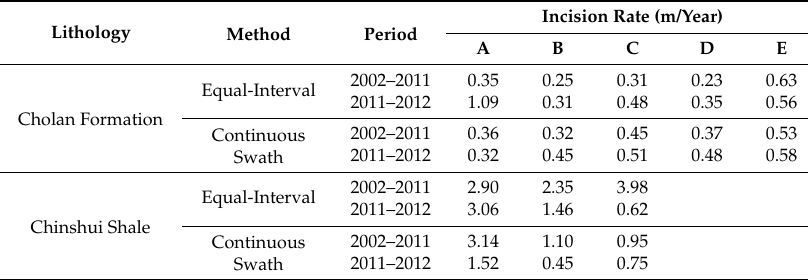
Table 4. Gully incision rate calculation results using the two different methods, i.e., equal-interval cross section selection method and continuous swath profiles selection